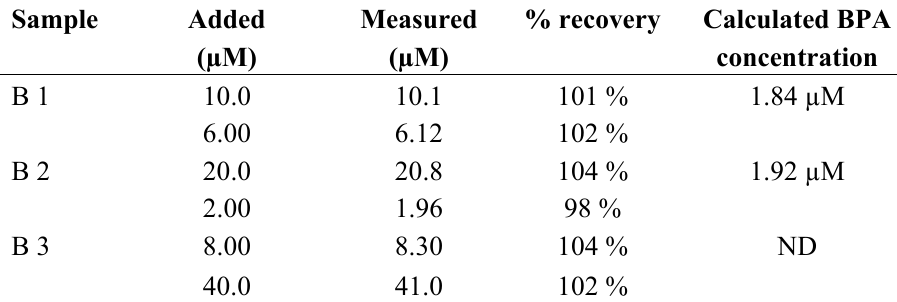
Table 2. Determination of BPA in plastic